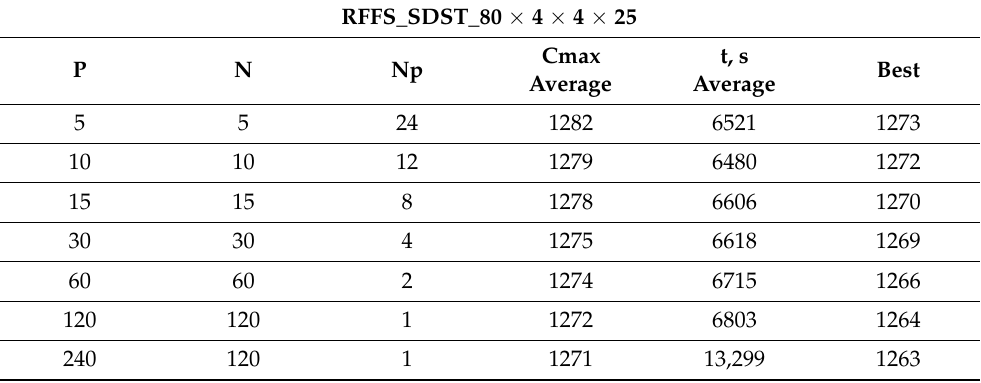
Table 10. RFFS_SDST_80 × 4 × 4 × 25 results.